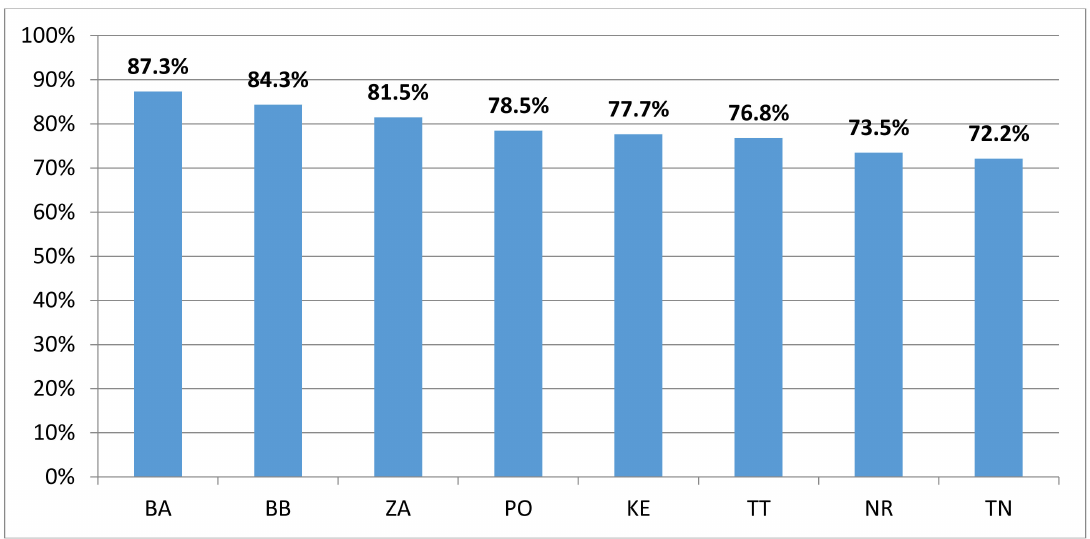
Figure 4. Share of rental land in the total area of land in the Slovak regions (NUTS III) in 2018. Source: own calculation on the basis of data from Slovak Land Fund, 2018. (Explanation of remarks: the Bratislava region (BA), the Trnava region (TT), the Trenˇc í n region (TN), the Nitra region (NR), the Žilina region (ZA), the Bansk á Bystrica region (BB), the Prešov region (PO) and the Košice region